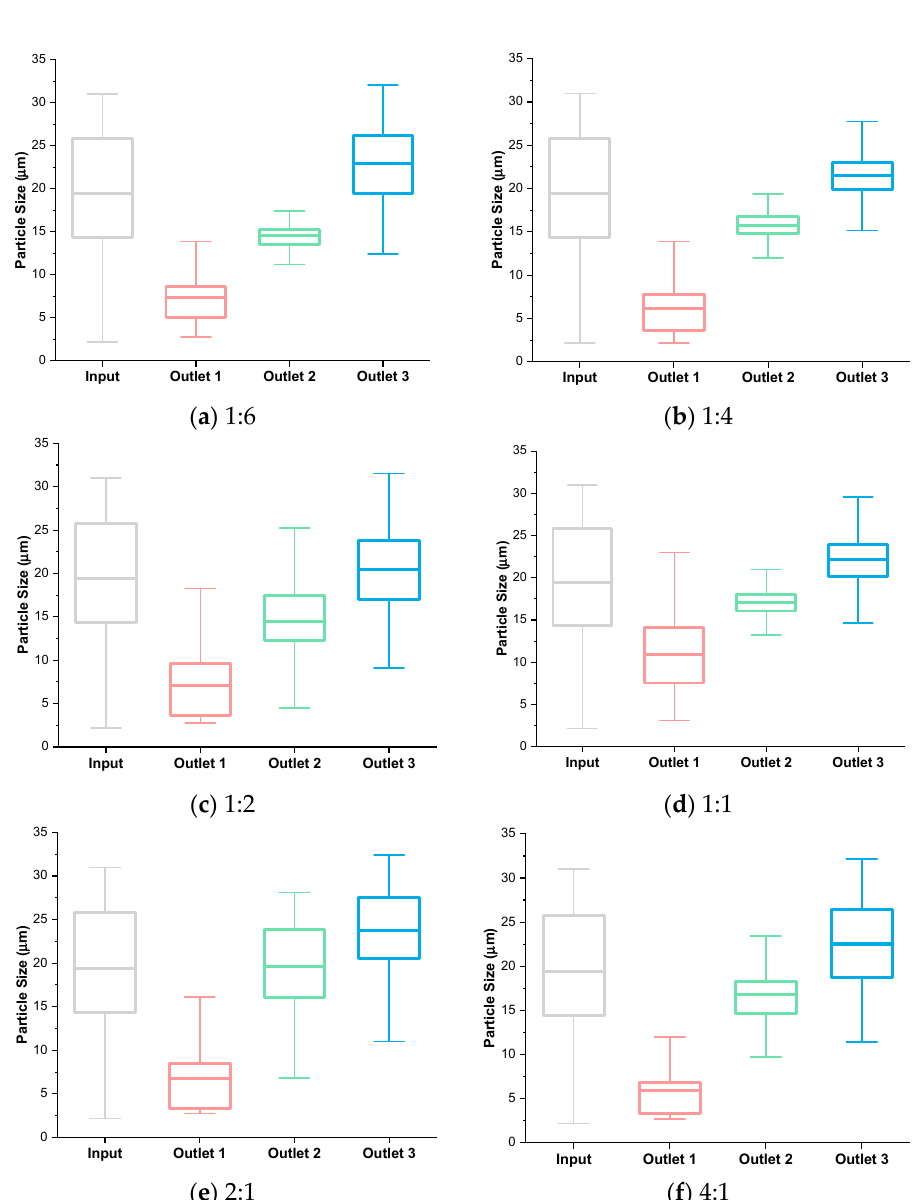
Figure A1. Distribution of particles within the outlets for various flow rate ratios. ( a ) 1:6 ratio had a larger distribution in outlet 3 compared to the 1:4 ratio. ( b ) 1:4 ratio had the most optimal refinement of the input distribution in all three outlets. ( c ) 1:2 ratio had a larger distribution in outlet 1 compared to the 1:4 ratio. ( d ) 1:1 ratio had a larger distribution in outlet 1 compared to the 1:4 ratio. ( e ) All outlets had larger distributions compared to the 1:4 ratio. ( f ) All outlets had larger distributions compared to the 1:4 ratio.